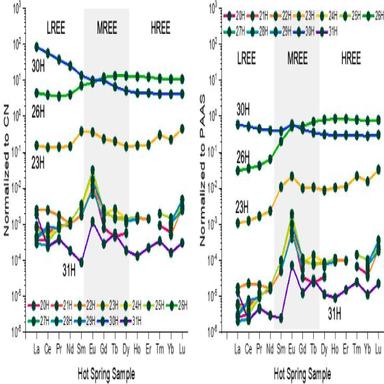
Spider-web diagrams of REE concentrations of the hot spring water samples normalized by CN and PAAS, highlighting the highest ΣREEs in the 26H and 30H acid–sulphate hot springs. The LREE enrichment in 30H is revealed more clearly by CN normalization diagram (left), suggesting advanced WRI in the upflow zone.